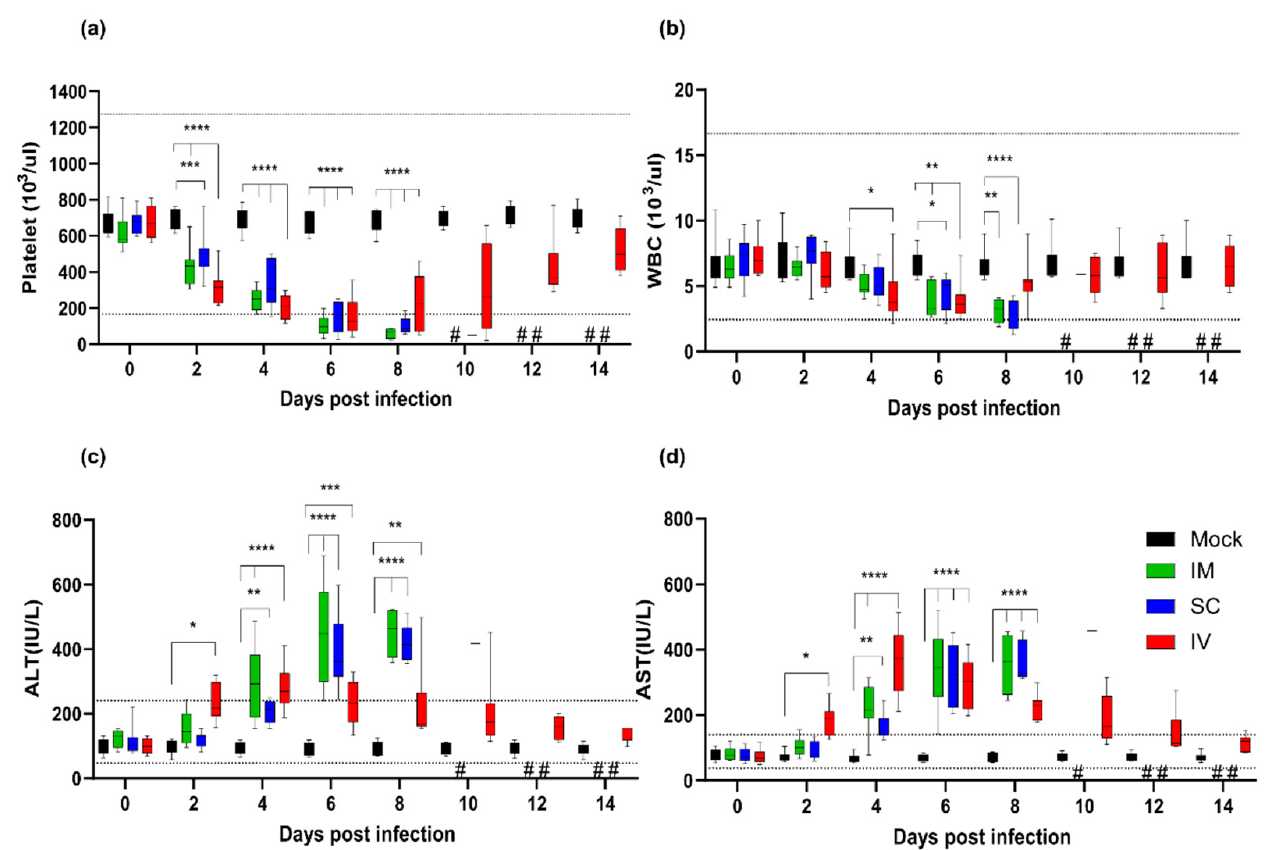
Figure 2. Hematological analysis of aged ferrets after inoculation with SFTSV via the IM, IV, and SC routes. Blood was collected every other day from the IM (green), SC (blue), and IV (red) groups for hematological analysis. ( a ) Platelet count; ( b ) white blood cell (WBC) count; ( c ) alanine aminotrans- ferase (ALT) levels; and ( d ) aspartate aminotransferase (AST) levels. Data are presented as min to max. An asterisk (*) indicates statistical significance when data are compared to those for the mock group by two-way ANOVA with Tukey’s comparison test (* p < 0.05; ** p < 0.01; *** p < 0.001; and **** p < 0.0001). A sharp symbol (#) indicates that no samples were collected because ferrets in the group died. The middle part of the dashed line is the normal value of the hematological parameters. Reference values for platelet, WBC, ALT, and AST are 171.7–1280.6 × 10 3 /µL, 2.5–16.7 × 10 3 /µL, 49– 242.8U/L, and 40.1–142.7U/L, respectively.